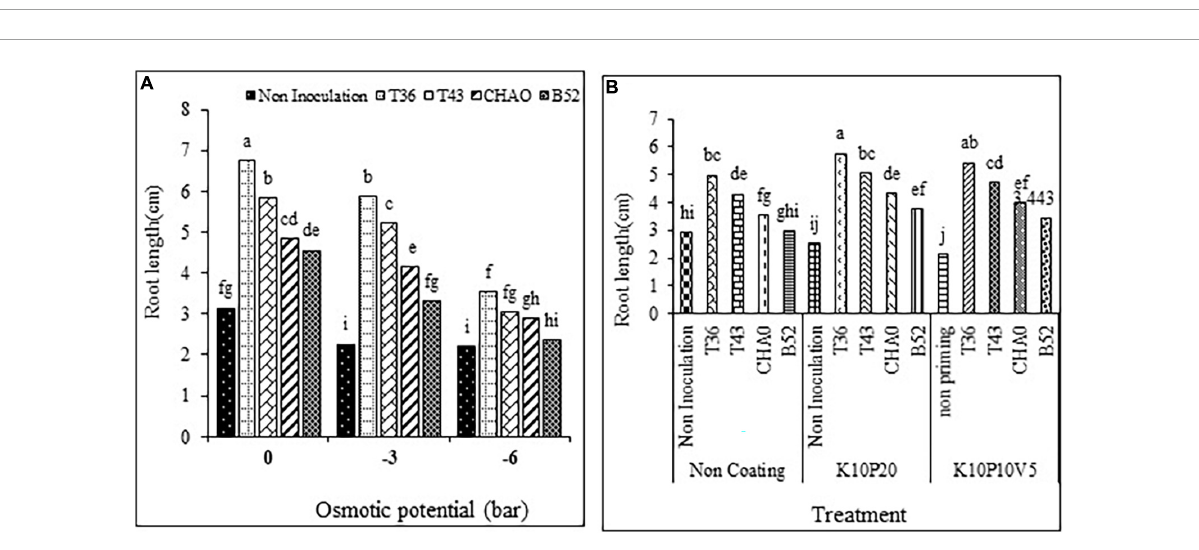
FIGURE8 Mean comparison of the effect of seed inoculation on seedling root length (in cm) of anise at different levels of (A) drought stress and (B) coating. Means with the same letter are not significantly different according to the HSD test at P = 0.05. CHA0, B52 of Pseudomonas fluorescens , T36 and T43 of Trichoderma harzianum isolates. K, kaolin; V, vermiculite; P,